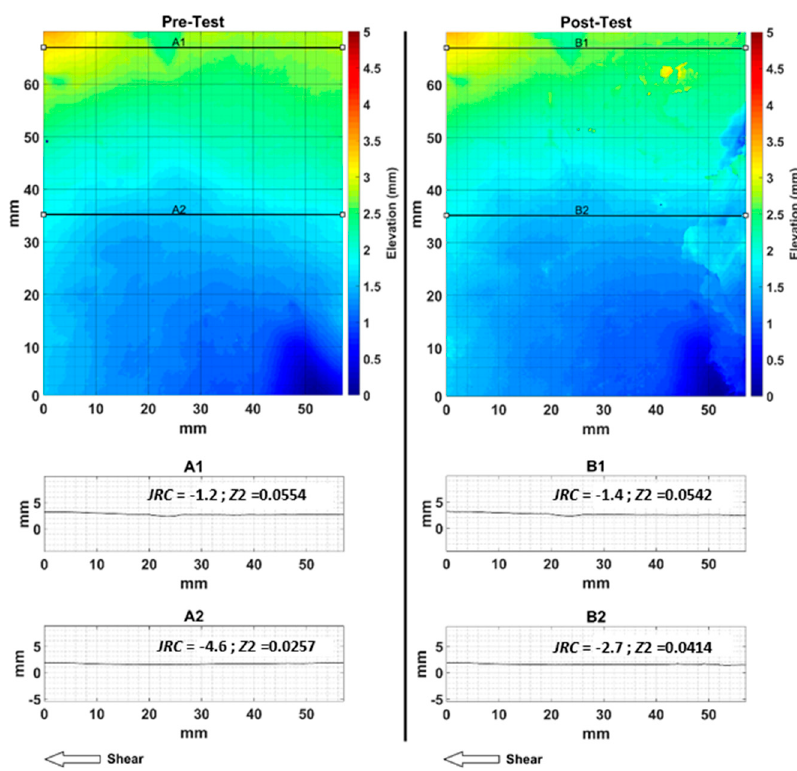
Figure 7. Topography of the fracture surface before and after the direct shear test (Draupne DST17). The arrow on the figure shows the direction of shearing. The roughness values of JRC and Z2 are portrayed with their respective profile. The negative values of JRC are equivalent to zero in the Barton-Bandis roughness chart.